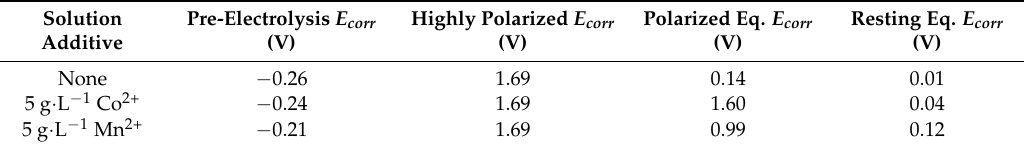
Table 1. E corr values (V vs. RHE) measured under open-circuit conditions during different equilibrium sweep voltammetry after electrolysis is highlighted in bold below as the most dependent on the catalytic metal ion present in